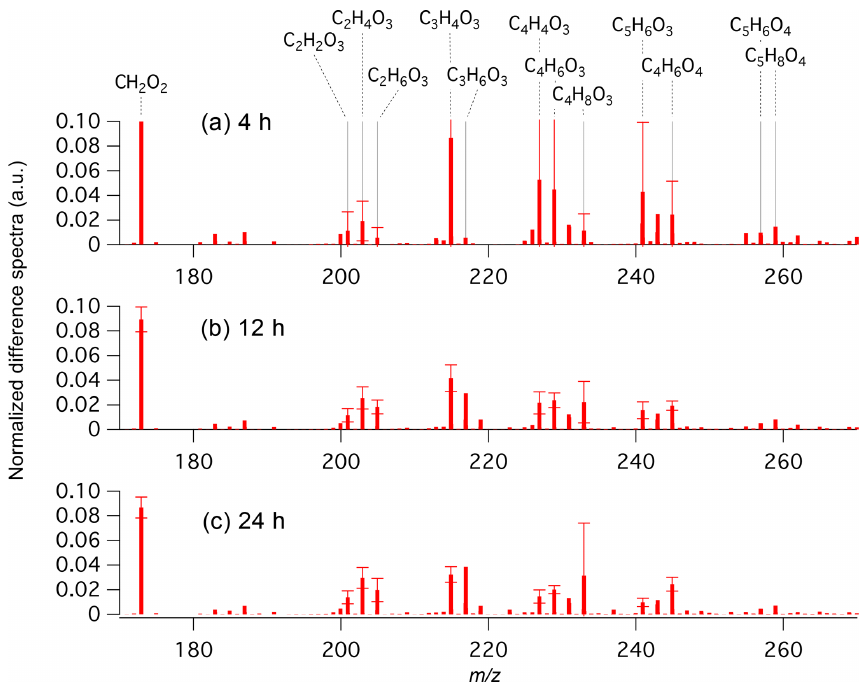
Figure 3. Summary of secondary NMOGs measured by I-CIMS during 12 mini-chamber experiments. Shown are ion signals that increased after initiating photochemistry relative to the total integrated signal measured prior to photochemistry. Panels (a) – (c) show changes in signal after 4, 12, and 24h of atmospheric-equivalent oxidation, respectively. Error bars represent standard deviations. Note that the masses are presented as I −